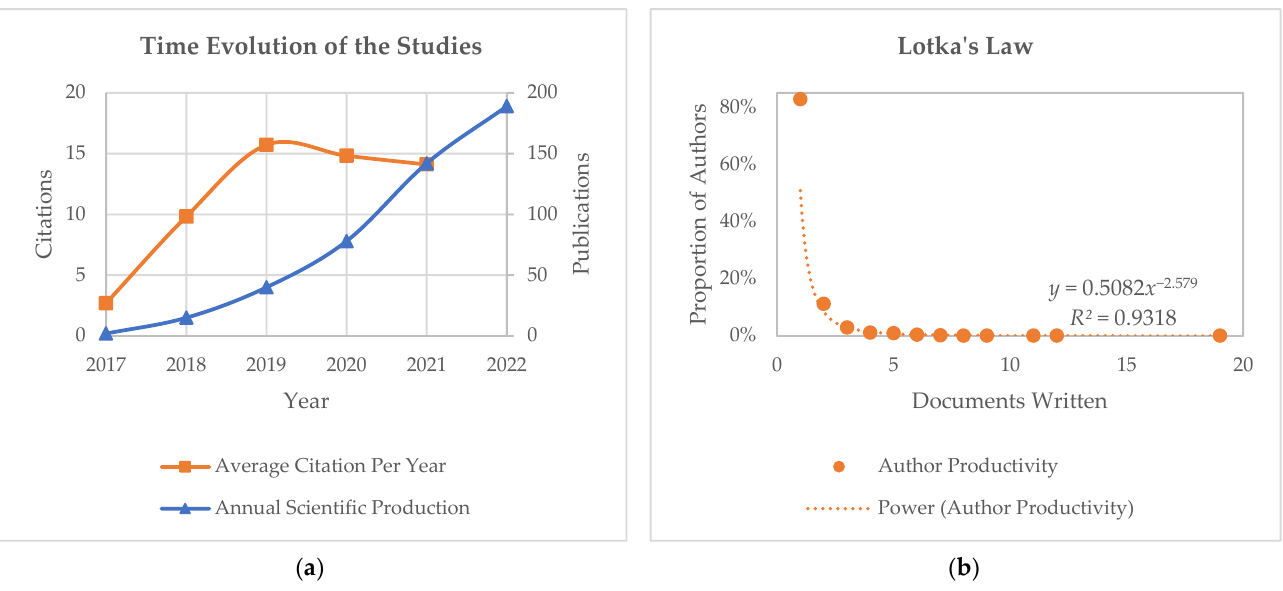
Figure 2. ( a ) Annual scientific production and average citations; ( b ) author productivity through Lotka’s Law.